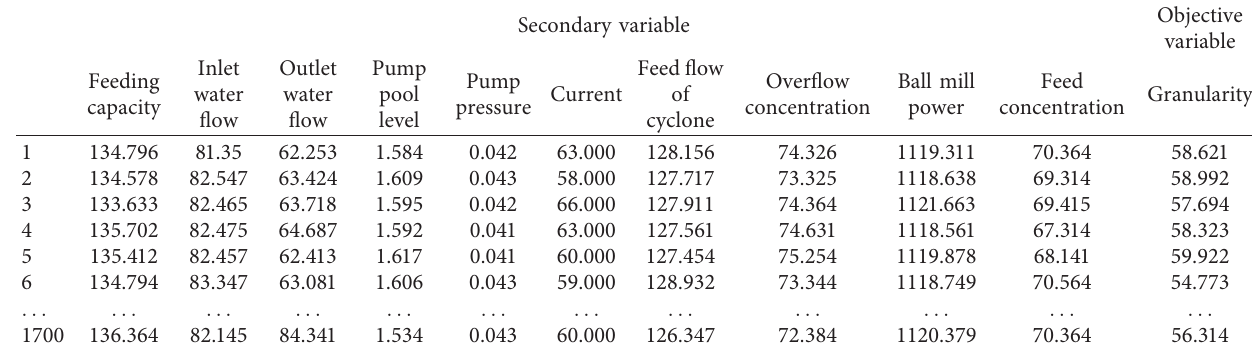
Table 3: Soft-sensor modeling data for the grinding process.